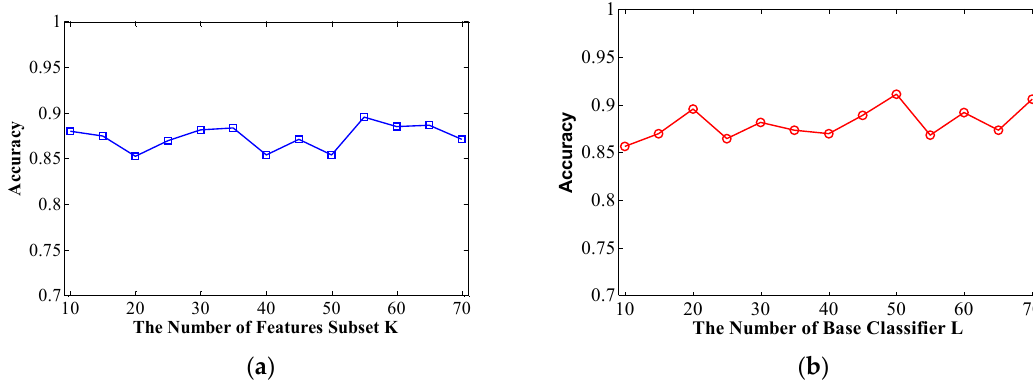
Figure 1. ( a ) Overall prediction accuracy rate with increasing K of feature subsets; ( b ) Overall prediction accuracy rate with increasing L of decision trees.